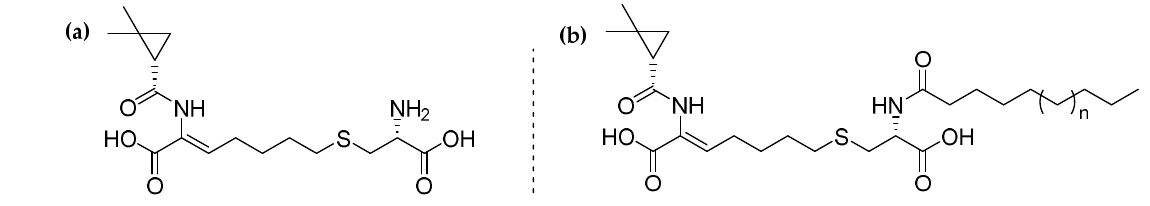
Figure 1. ( a ) Cilastatin and ( b ) drug-structure-directing agents from cilastatin.